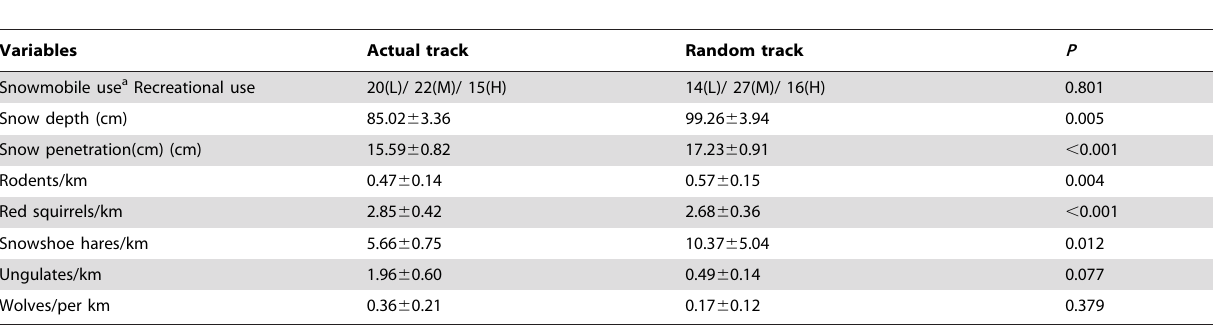
Table 3. Multi-Response Permutation Procedure (MRPP) testing for differences in variable means ( 6 SE) between actual tracks (265 km) and random tracks (279 km) in northwestern Wyoming, 2007–2008.